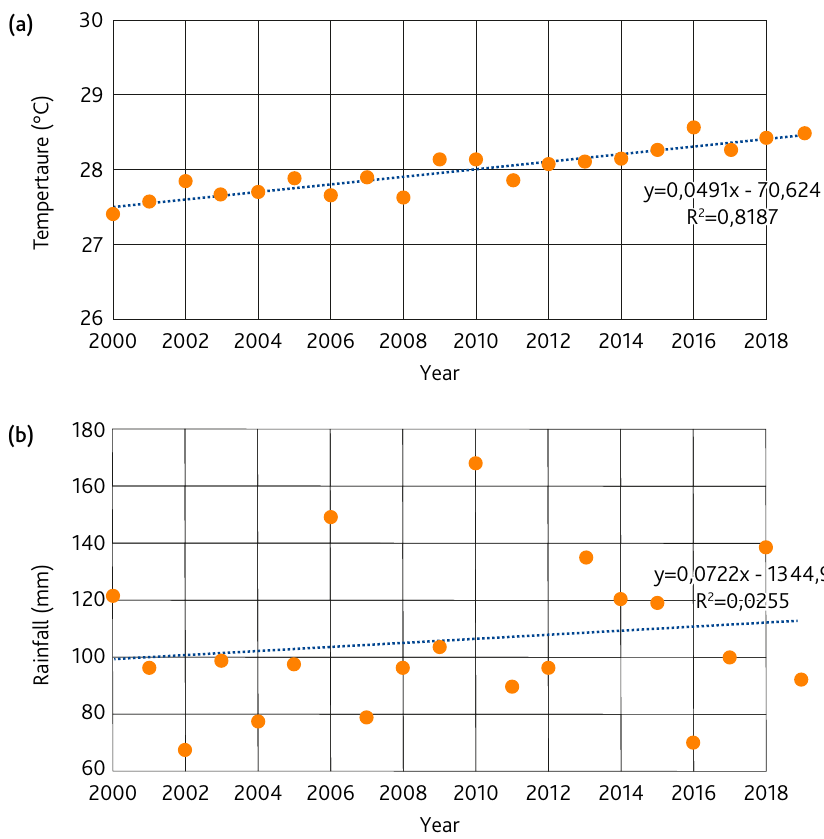
Figure 8. Trend of temperature rise (a) and maximum annual rainfall (b) in the Pekalongan area